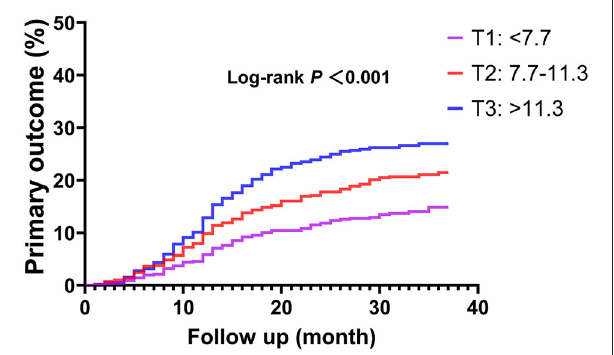
FIGURE 2 | Kaplan-Meier curve of the primary endpoint stratified by the MHR tertiles. The primary endpoint was defined as the composite of overall death, non-fatal stroke, non-fatal MI, and unplanned repeat revascularization. MI, myocardial infarction.